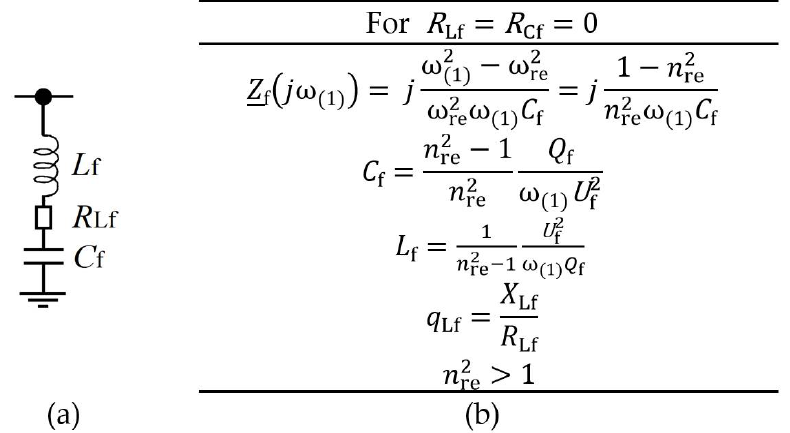
Figure 12. ( a ) Single-tuned filter, ( b ) expressions used to compute the single-tuned filter parameters. ω re —resonance frequency, n re —harmonic order at the resonance, q Lf —reactor quality factor, ω (1) =2π f (1) .